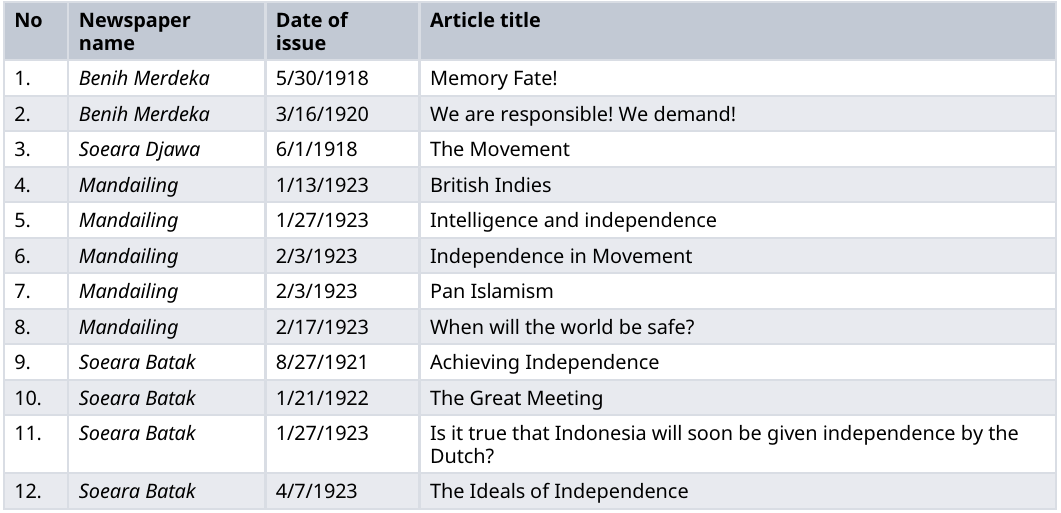
Table 4. The newspapers that demand Indonesian independence